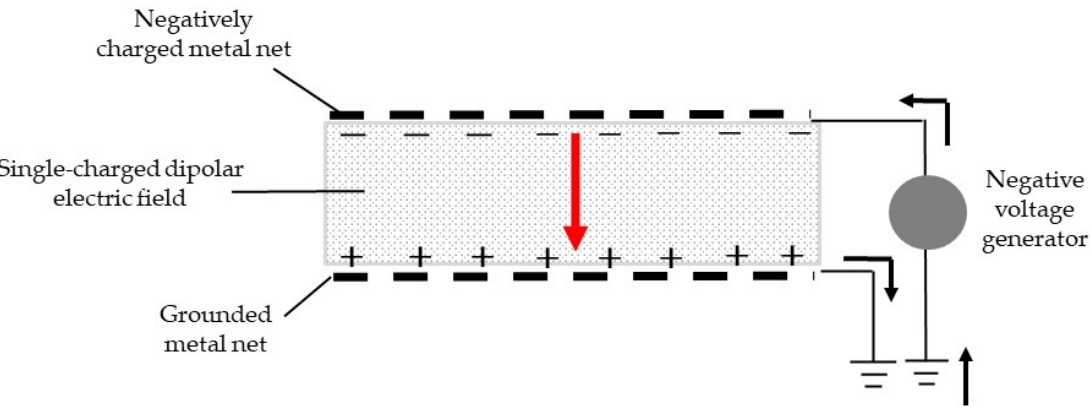
Figure 1. Schematic representation of a single-charged dipolar electric field formed between a negatively charged metal net and a grounded metal net. The black arrow represents the movement of the negative current, and the red arrow represents the movement of electricity through arcing.